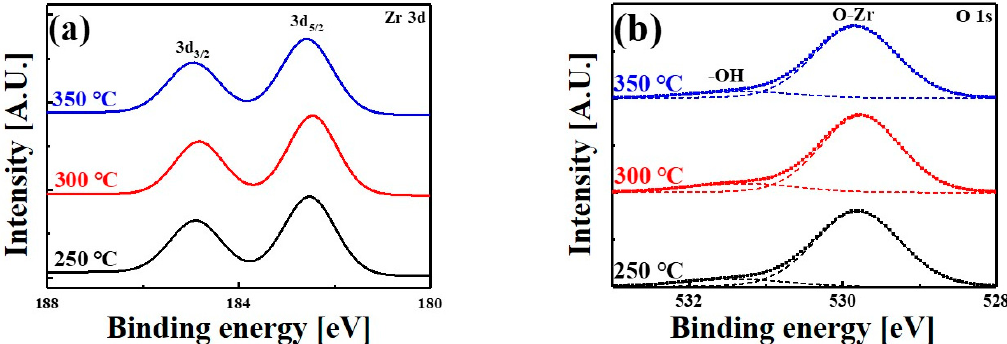
Figure 1. ( a ) Zr 3d and ( b ) O 1s spectra of ZrO 2 films grown at different temperatures. Table 1. Zirconium (Zr) three-dimensional (3d) peak positions and spin-orbit splitting (SOS) of zirconium oxide (ZrO 2 ) films grown at different